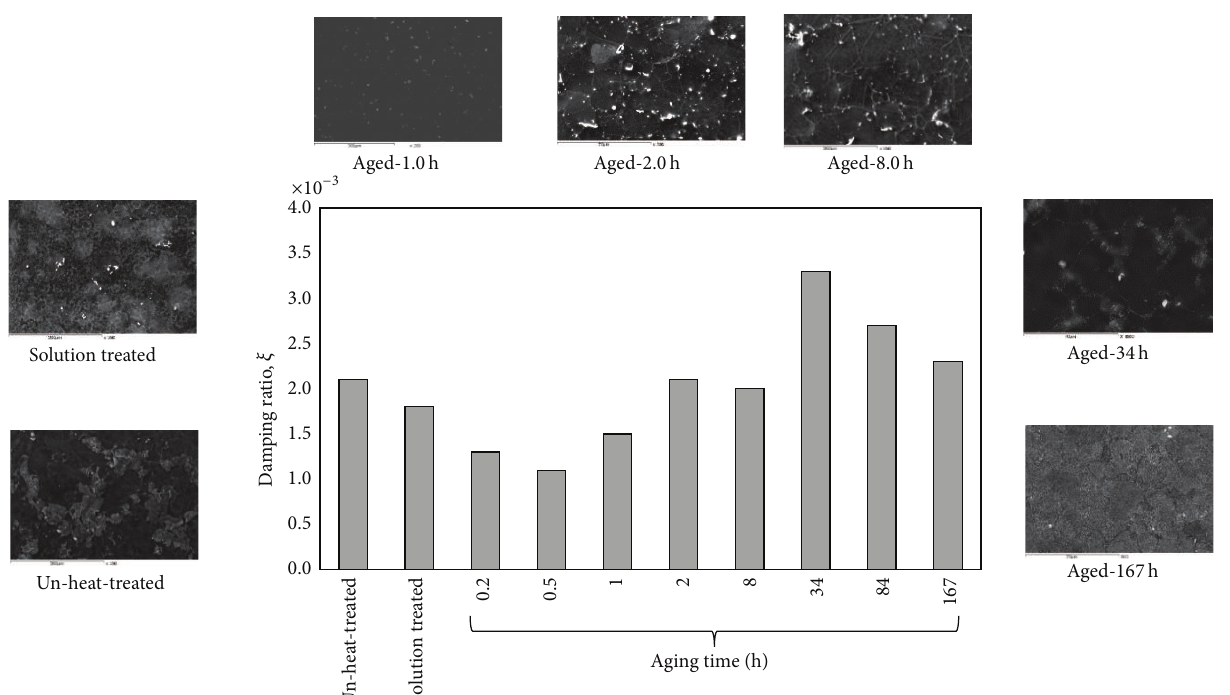
Figure 5: The corresponding damping ratio as a function of the aging time, compared with the un-heat-treatment and solid solution treated